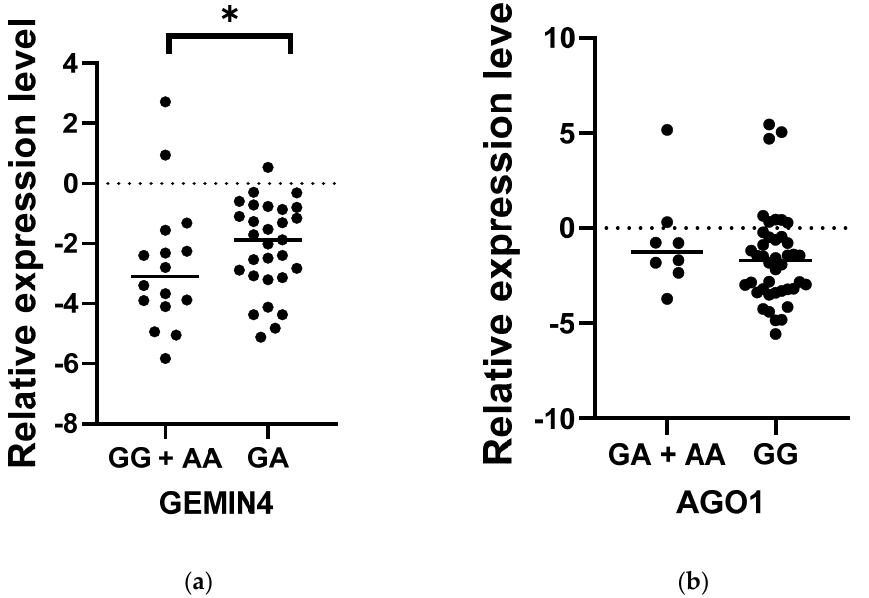
Figure 2. Comparison of the expression level of GEMIN4 rs7813 ( a ) and AGO1 rs636832 ( b ) genetic variants in the group of patients with MS. Statistical analysis of differences between the groups of data was carried out using the Mann–Whitney U-test (* indicate statistical significance at a p < 0.05).